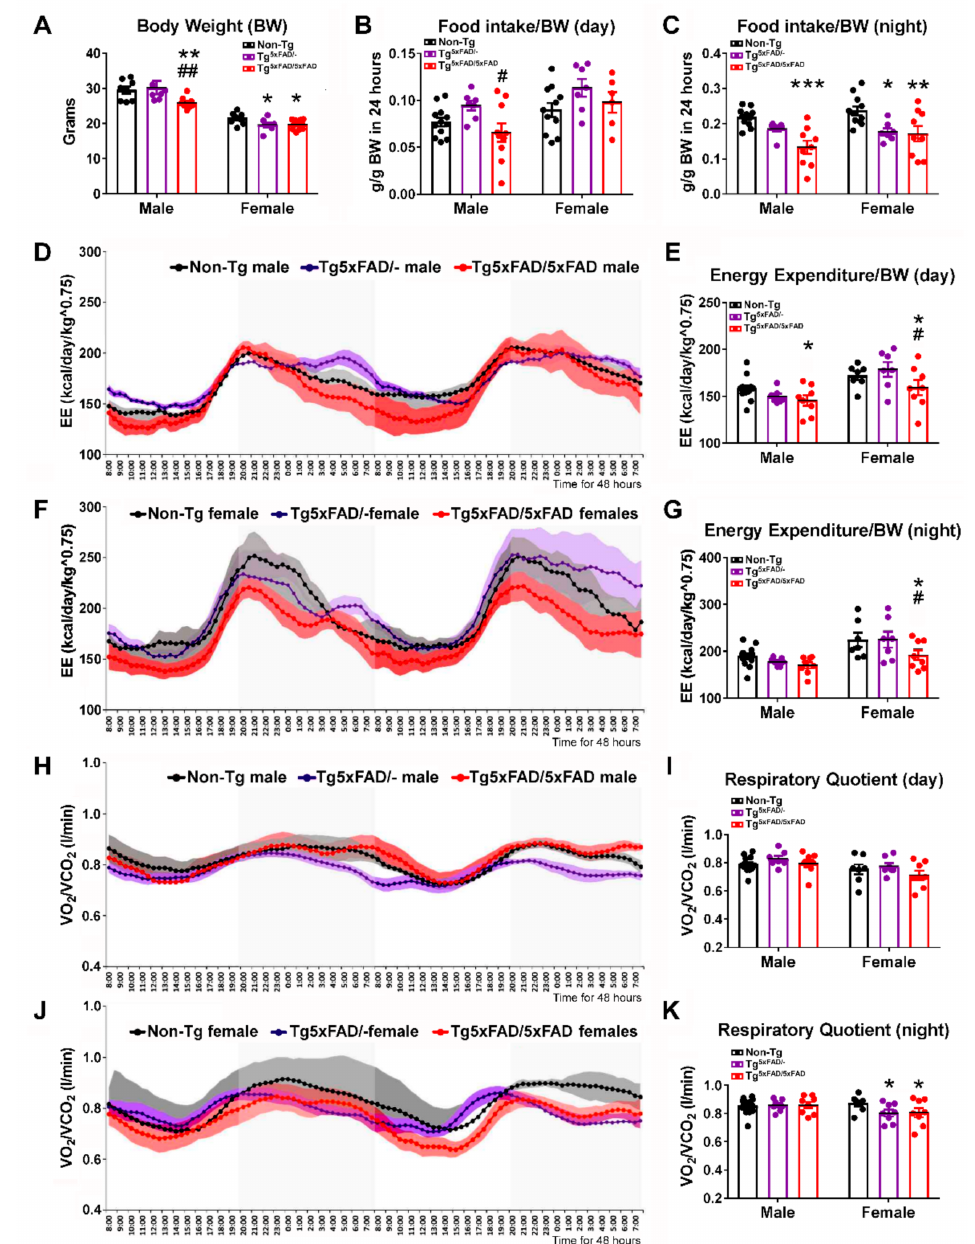
Figure 1. Negative energy balance in 5xFAD mice was associated with decreased food intake and energy expenditure for 48 h. ( A ) Body weight showing significantly decreased body weight in Tg 5xFAD/5xFAD males, Tg 5xFAD/- females, and Tg 5xFAD/5xFAD females at 6 months of age. ( B , C ) Decreased food intake per body weight in Tg 5xFAD/5xFAD males during the day (light phase, 8 a.m. to 8 p.m.) and night (dark phase, 8 p.m. to 8 a.m.). Decreased food intake also occurred in Tg 5xFAD/- females and Tg 5xFAD/5xFAD females during the night. ( D – G ) Energy expenditure normalized per body weight (EE/BW) in males and females, showing decreased mean EE/BW in Tg 5xFAD/5xFAD males during the day, and in g 5xFAD/5xFAD females during the day and night. ( H – K ) Respiratory quotient showing decreased ratio of vO2/vCO2 in Tg 5xFAD/- females and Tg 5xFAD/5xFAD females during the night, indicating decreased glucose utilization/increased fatty acid oxidation as energy source. n = 7–15 per group. Two-way ANOVA analysis with Tukey’s post hoc test: * = p < 0.05, ** = p < 0.01, *** = p < 0.001 versus same-sex non-Tg group; # = p < 0.05, ## = p < 0.01 versus same-sex Tg 5xFAD/-